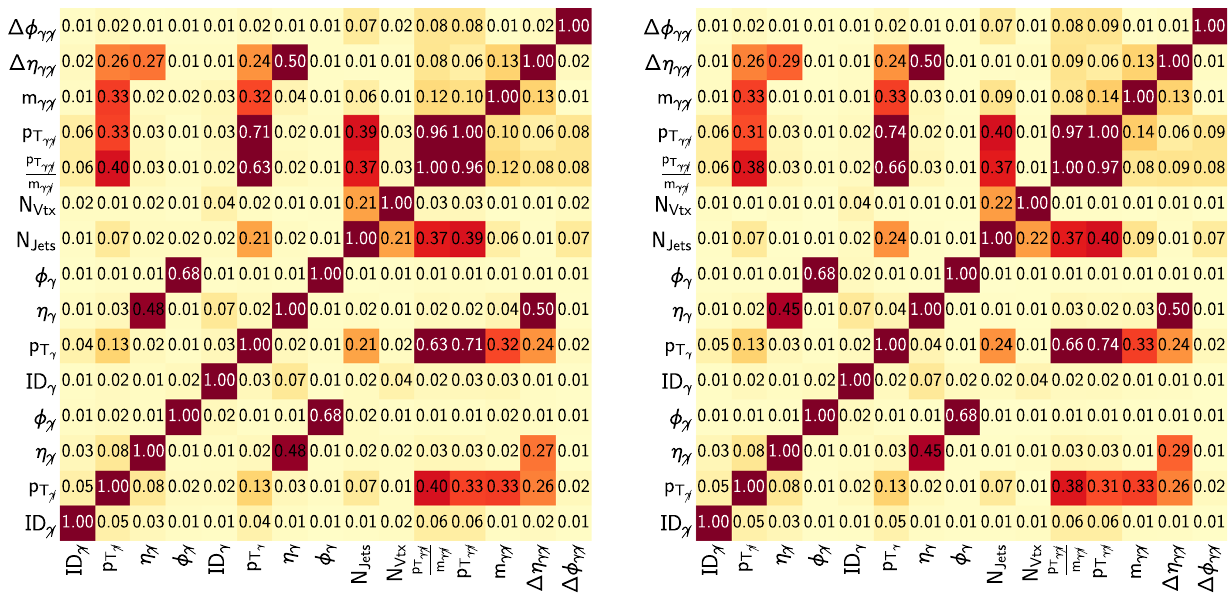
Fig. 7 Correlation matrices computed using the distance correlation on the MC SR (left) and on sample produced from the GAN application to the MC CR (right)